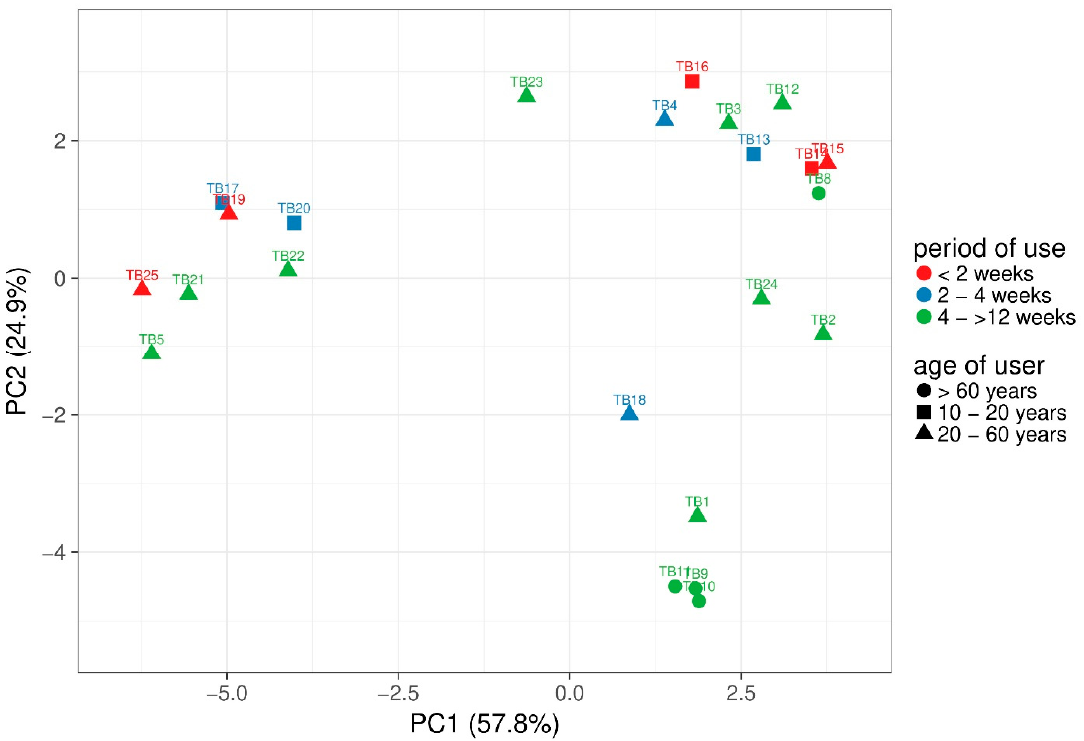
Figure 2. Principal component analysis (PCA) of toothbrush samples ( n = 23) based on weighted UniFrac distance analysis. Unit variance scaling was applied to rows and NIPALS (Nonlinear Iterative Partial Least Squares) PCA was used to calculate principal components. X- and Y-axis show principal component 1 and principal component 2 that explain 57.8% and 24.9% of the total variance, respectively. Period of use: < 2 weeks ( n = 6), 2–4 weeks ( n = 6), 4– > 12 weeks ( n = 11)) and user age: (10–20 years ( n = 5), 20–60 years ( n = 14), > 60 years ( n = 4)).